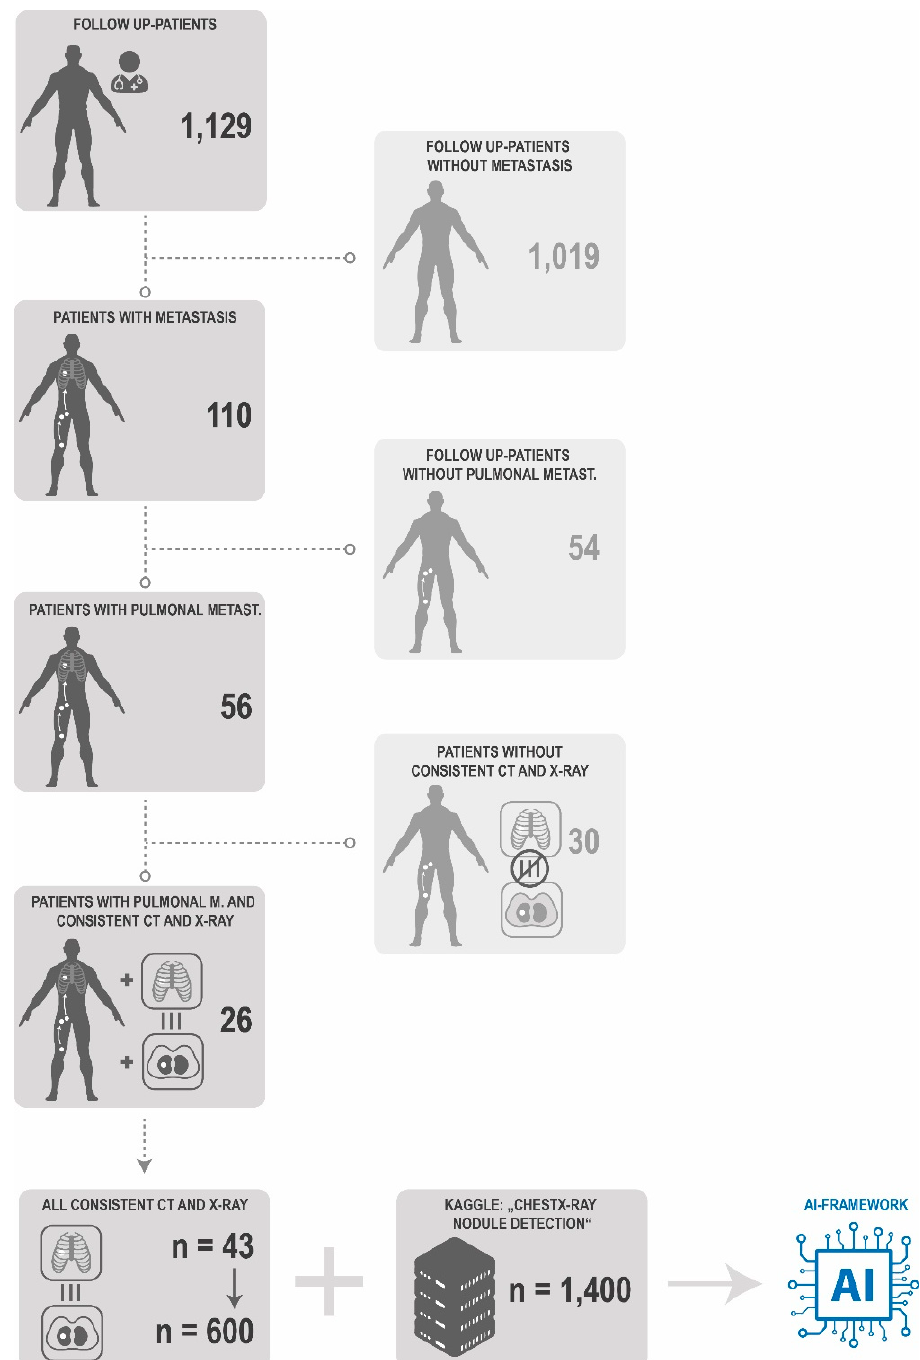
chest X-rays with sarcoma metastasis nodules were available. The data and patient inclu- sion as well as the training algorithm is depicted in Figure 1.